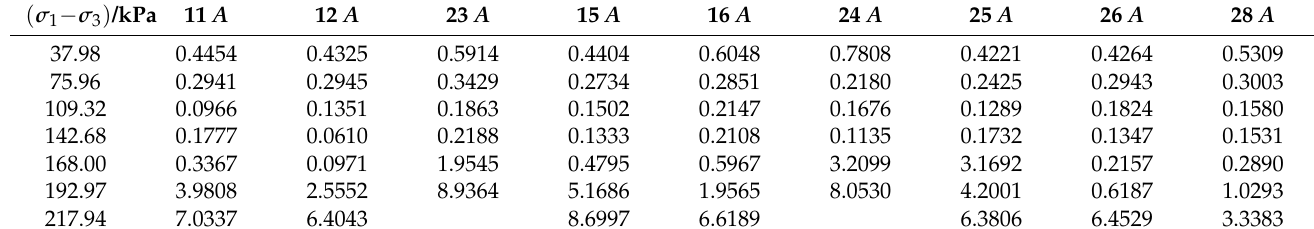
Table 6. The fitting A values of all the specimens under all the ADS levels.